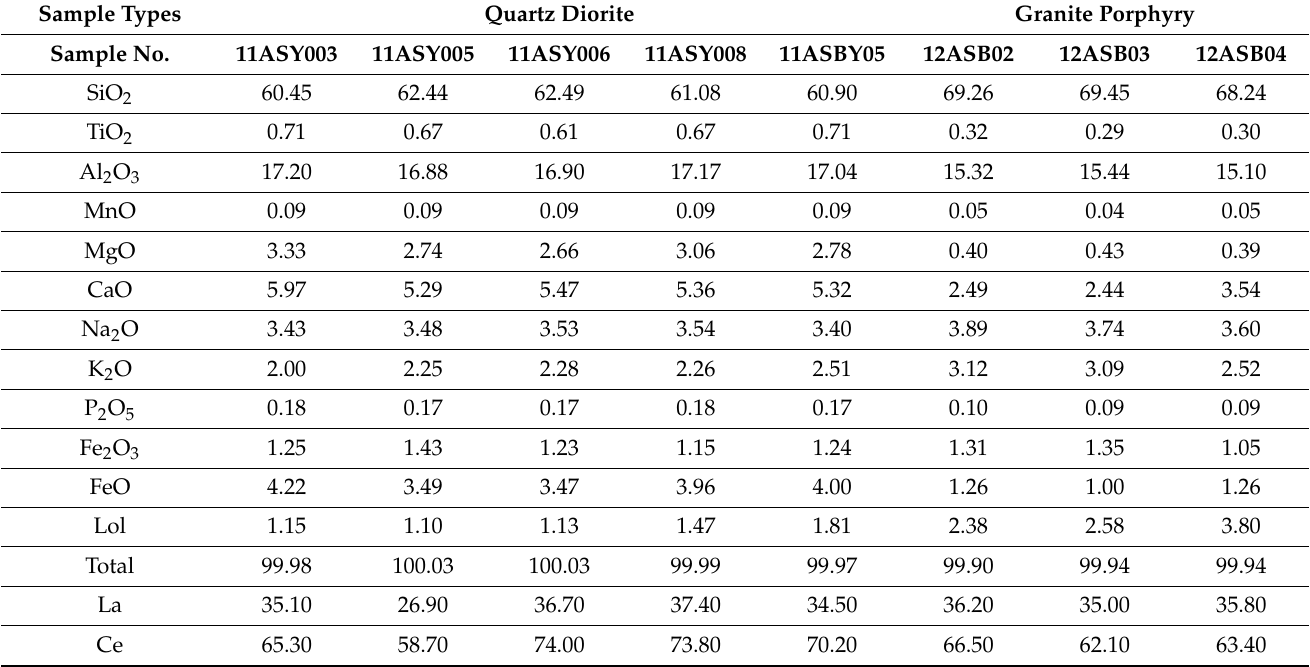
Table 2. Major elements (%) and trace elements (ppm) of Asiha